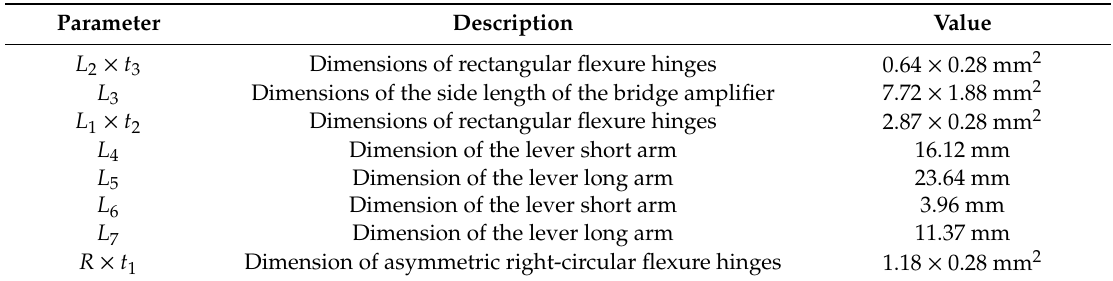
Table 1. Optimized